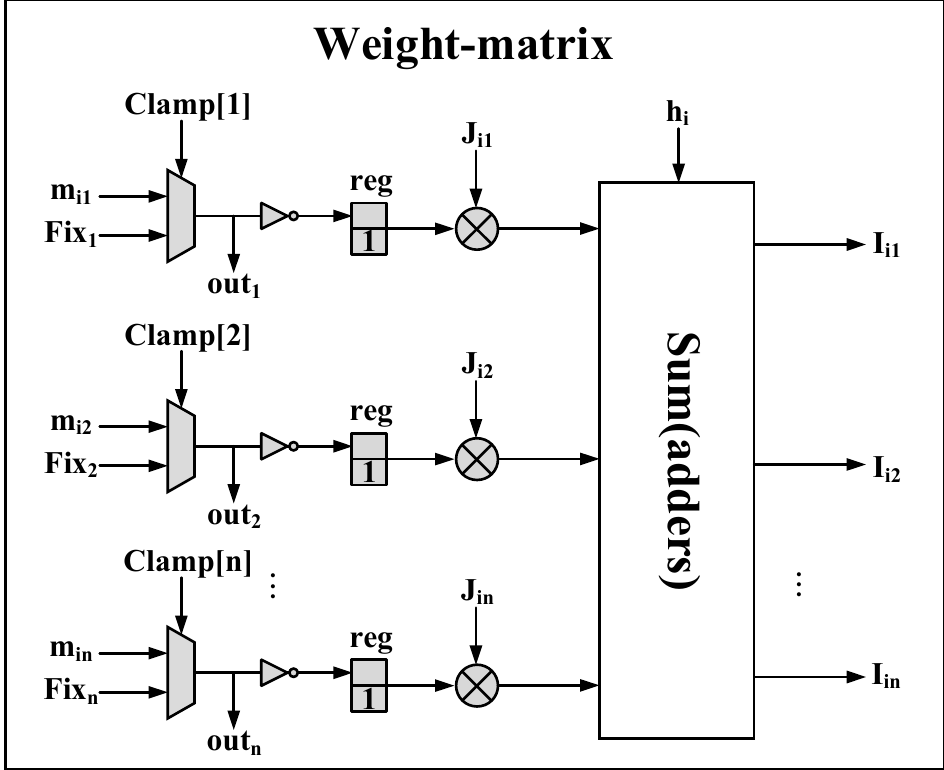
Figure 4. The structure of the weight-matrix. MUXs are used to choose the fluctuation value ( m in ) or a certain value ( Fix n ). 2-bit signed registers with LSB fixed to 1 are used to convert p-bit output m ∈ { 0,1 } to a bipolar m ∈ {− 1, + 1 }